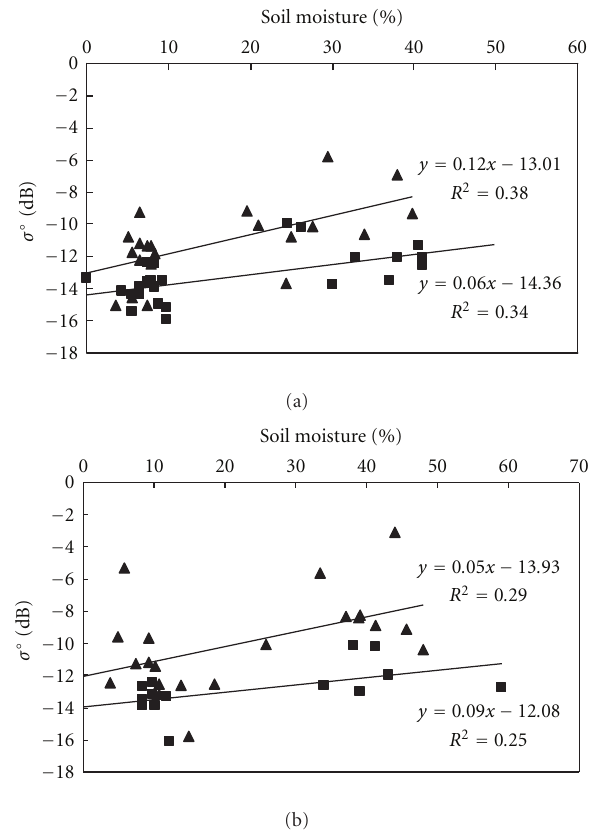
Figure 5: Linear regression models between backscattering coef- ficient, σ ◦ , with ground measured soil moisture (0–5 cm depth) for soil drainage types: (a) moderate to good drainage and (b) poor drainage. Symbols for each field class; tilled (triangle), untilled